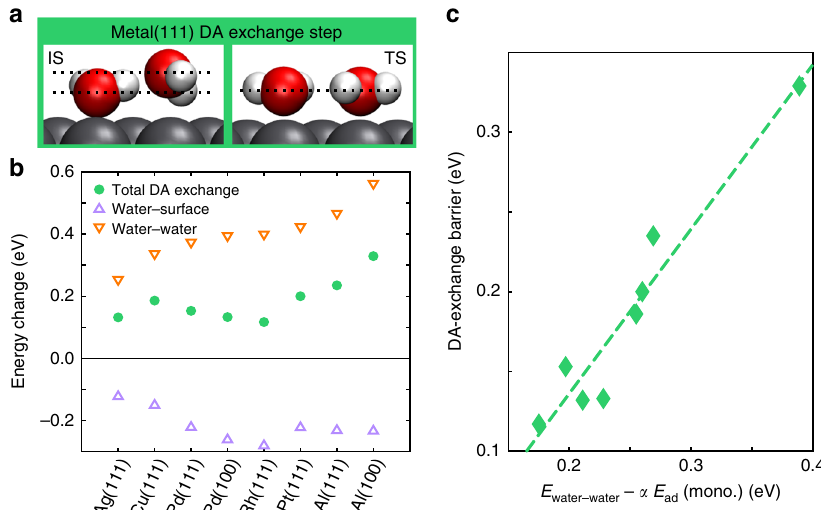
Fig. 3 Trends in water dimer waltz diffusion on metals. a Side view of the water dimer of the initial state (IS) and transition state (TS) of the DA exchange process on Pd(111), viewed from the [211] direction. The dotted lines indicate the heights of the two water molecules. b Decomposition of the energy change between the TS and the IS for water dimer DA exchange on metal surfaces. c Correlation between the potential energy barrier of the DA exchange step on metal surfaces and a characterisation quantity de fi ned by the water – water interaction (Eq. (1)) and water monomer adsorption energy, with α = 0.5. The dashed line is a linear regression of the data points ( R 2 =